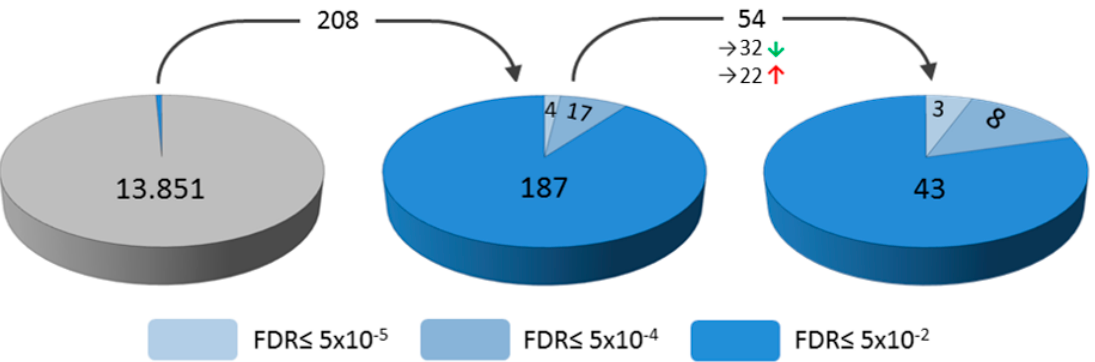
Figure 1. Analyses of transcriptome alterations in CuFi cells. Alterations during human bocavirus (HBoV) infection of mock-infected CuFi-8 cells vs. HBoV-infected CuFi-8 cells. A total number of 208 genes out of 13,851 genes were regulated with statistically approved significance (False Discovery rate FDR ≤ 0.05). Of these 54 genes were HBoV-specific regulated. These 54 genes have been identified by comparison of mock-infected CuFi-1 and -5 transcriptomes with the mock-infected CuFi-8 transcriptome. Therefore, transcripts of HBoV-infected CuFi-8 cells, of which the RNA level in mock-infected CuFi-8 differs from mock-infected CuFi-1 and CuFi-5 cells, were excluded from the set of 208 transcripts. Of the 54 genes, 22 were upregulated, while 32 were downregulated. The experiments were separately performed in triplicate, based on three independent infections per cell line.